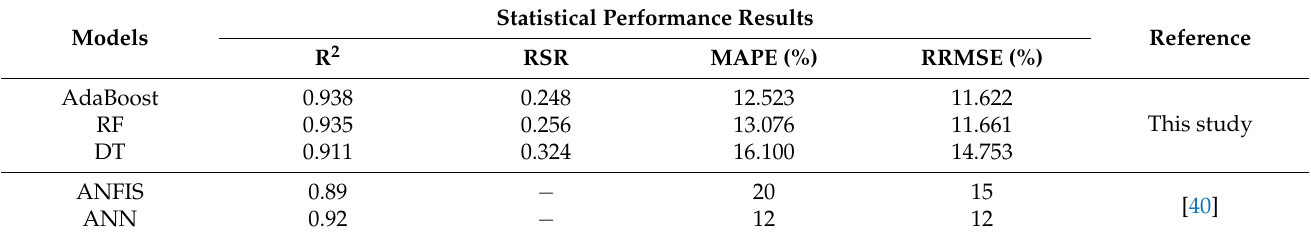
Table 5. Comparison of statistical results obtained from the applied predictive models using testing phase with available ANFIS and ANN